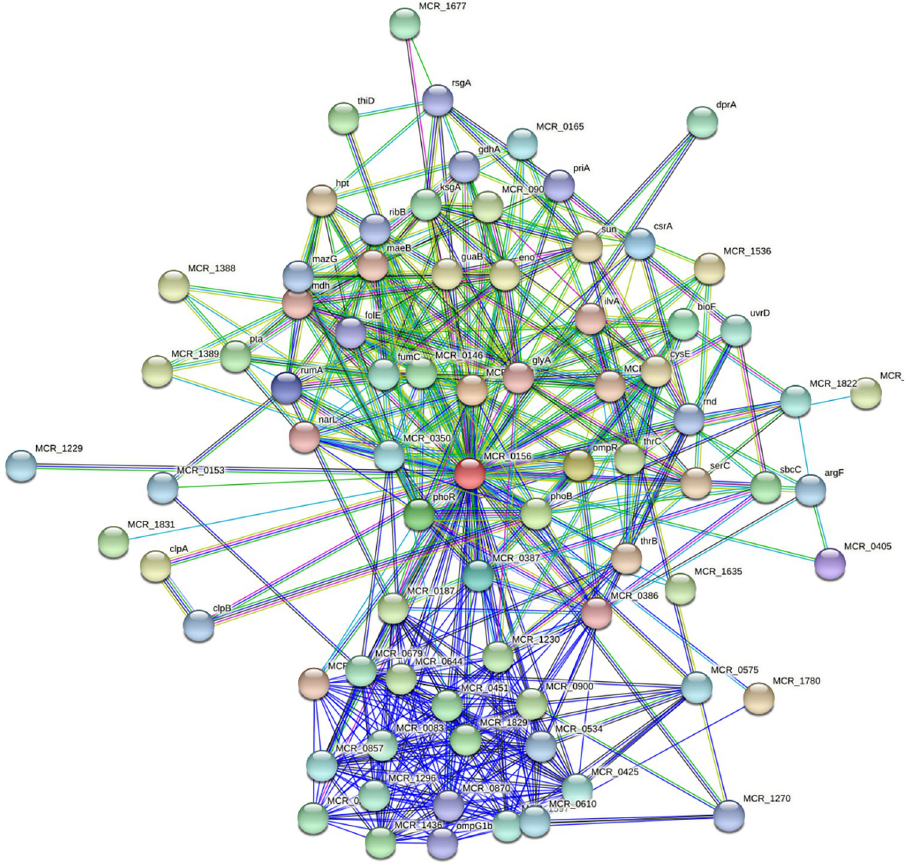
Fig 8. Protein-protein interactions: Schematic PPI network generated through the STRING database for histidine kinase.